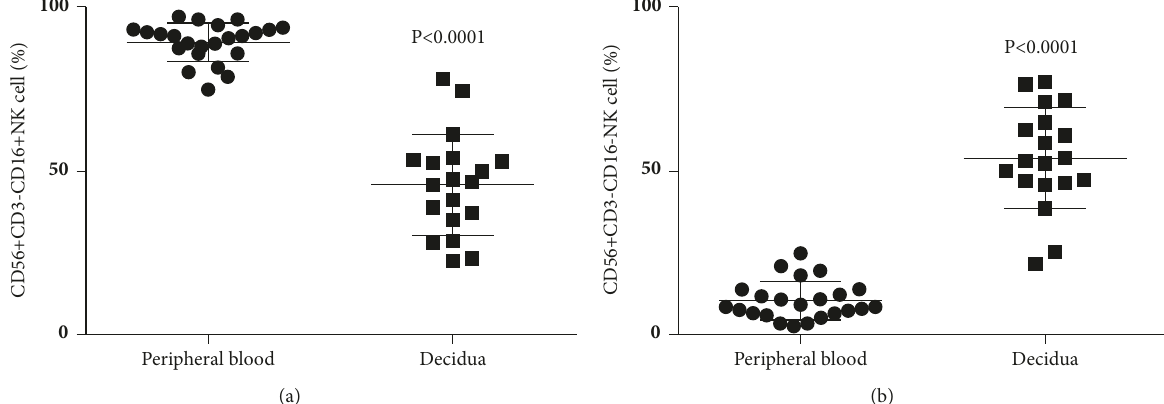
Figure 2: (a) Percentage of CD56+CD3-CD16+ cells among CD56+CD3- cells at term pregnancy in peripheral blood and decidua. The percentages of CD56+CD3-CD16+ lymphocytes in decidual cells were lower than those in peripheral blood. (b) Percentage of CD56+CD3- CD16- cells among CD56+CD3- cells at term pregnancy in peripheral blood and decidua. The percentages of CD56+CD3-CD16- lymphocytes in decidual cells were higher than those in peripheral